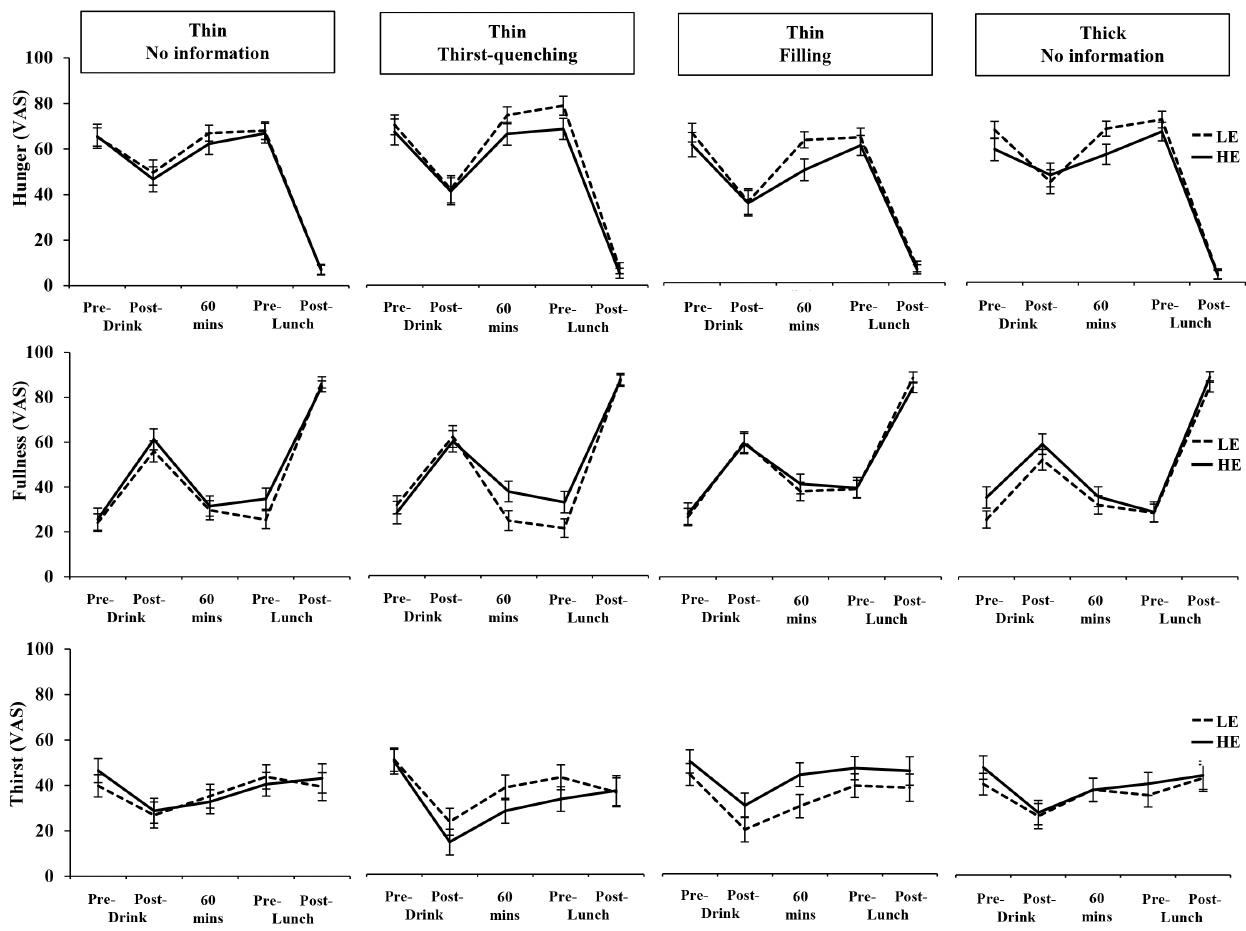
Figure 4. Hunger, fullness and thirst VAS ratings pre-drink, post-drink, 60 minutes later, pre-lunch and post-lunch, across each of the drink context groups.